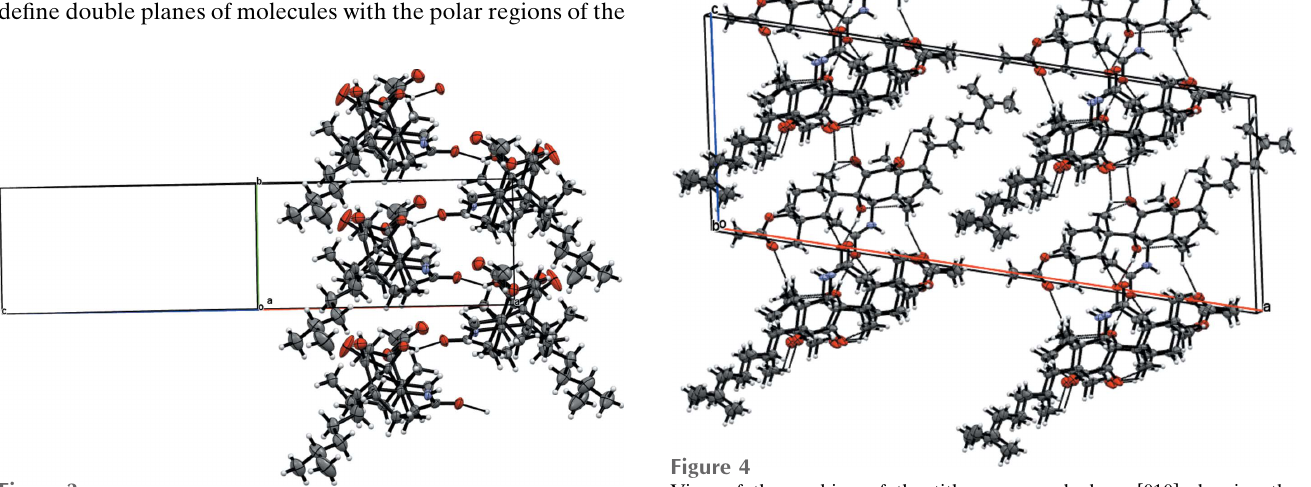
Figure 3 Zigzag chains of molecules connected by O7—H7 (cid:2)(cid:2)(cid:2) O2( (cid:4) x + 3 interactions along the b- axis direction.